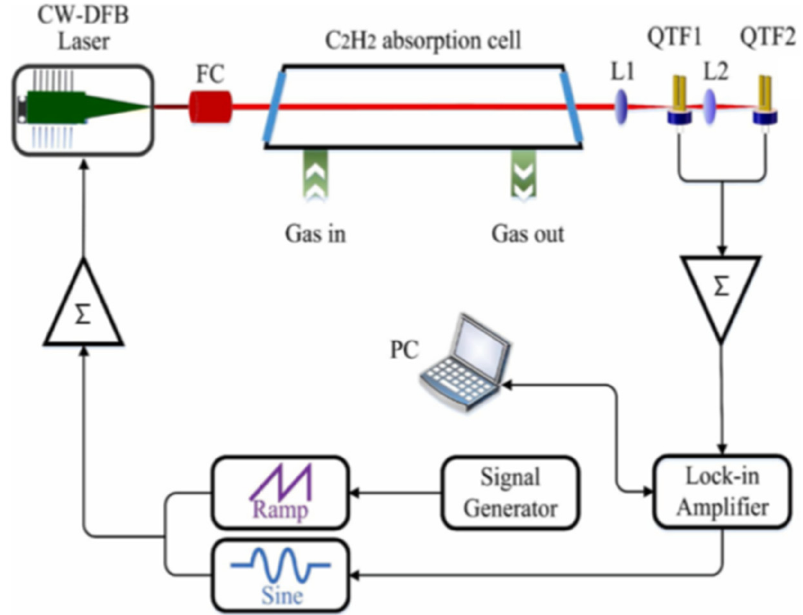
Figure 7. Experimental setup of the multi-QTF-based LITES sensor system. Reprinted/adapted with permission from Ref. [112]. Copyright 2020, copyright Elsevier.